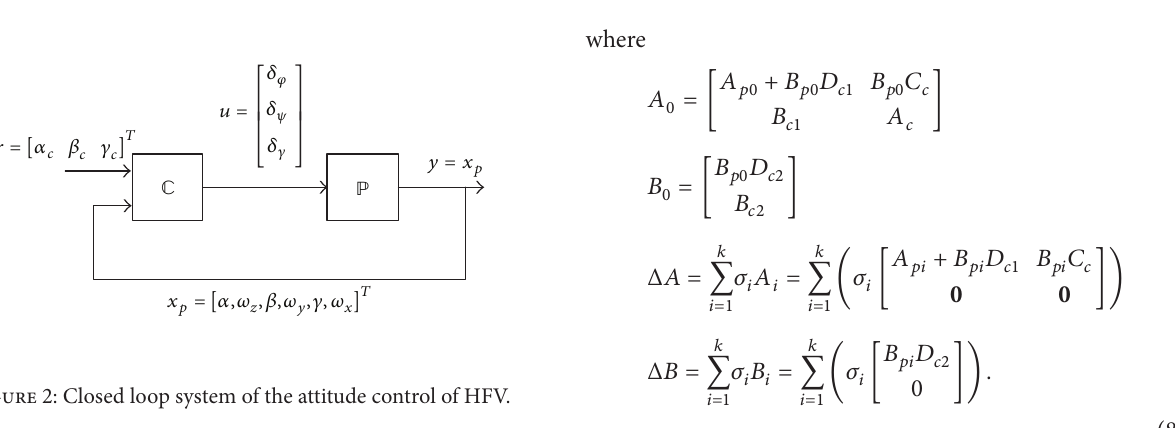
Figure 2: Closed loop system of the attitude control of